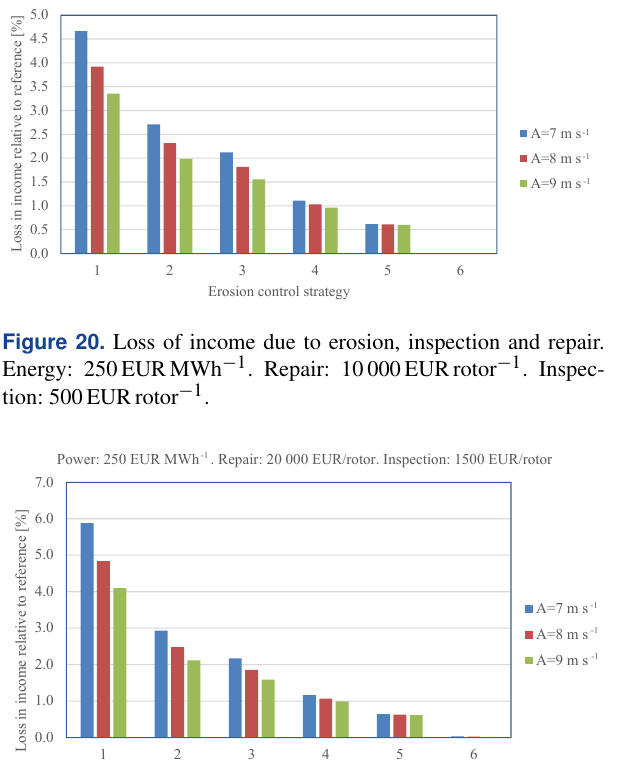
Figure 21. Loss of income due to erosion, inspection and repair. Energy: 250EURMWh − 1 . Repair: 20000EURrotor − 1 . Inspec- tion: 1500EURrotor − 1